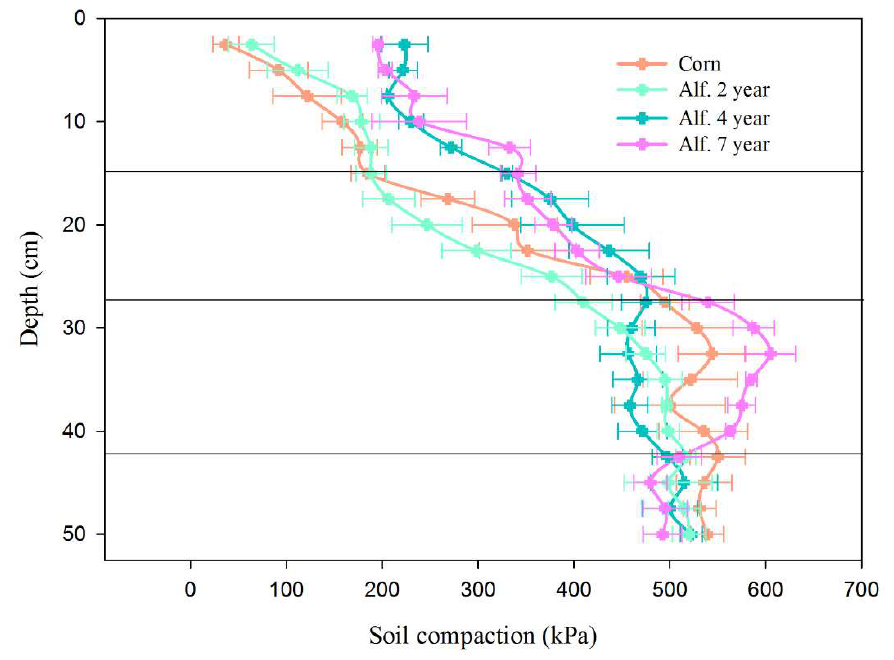
Figure 4. Vertical variation of the soil compaction in the cornfield and in the two-, four- and seven-year-old alfalfa pastures at 0–50 cm soil depth.